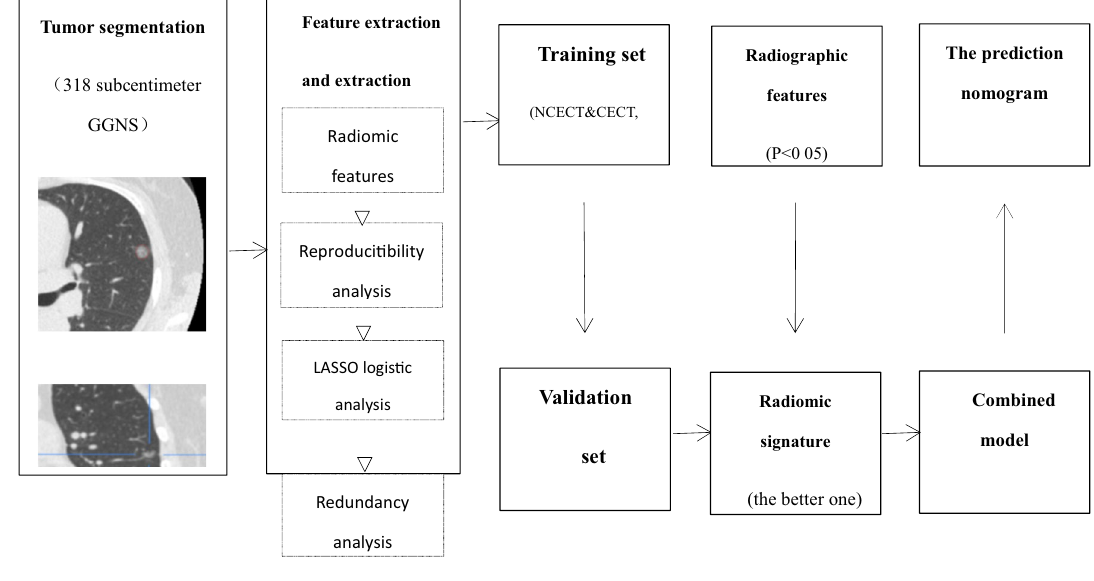
Figure 1. The workflow of radiomics analysis.